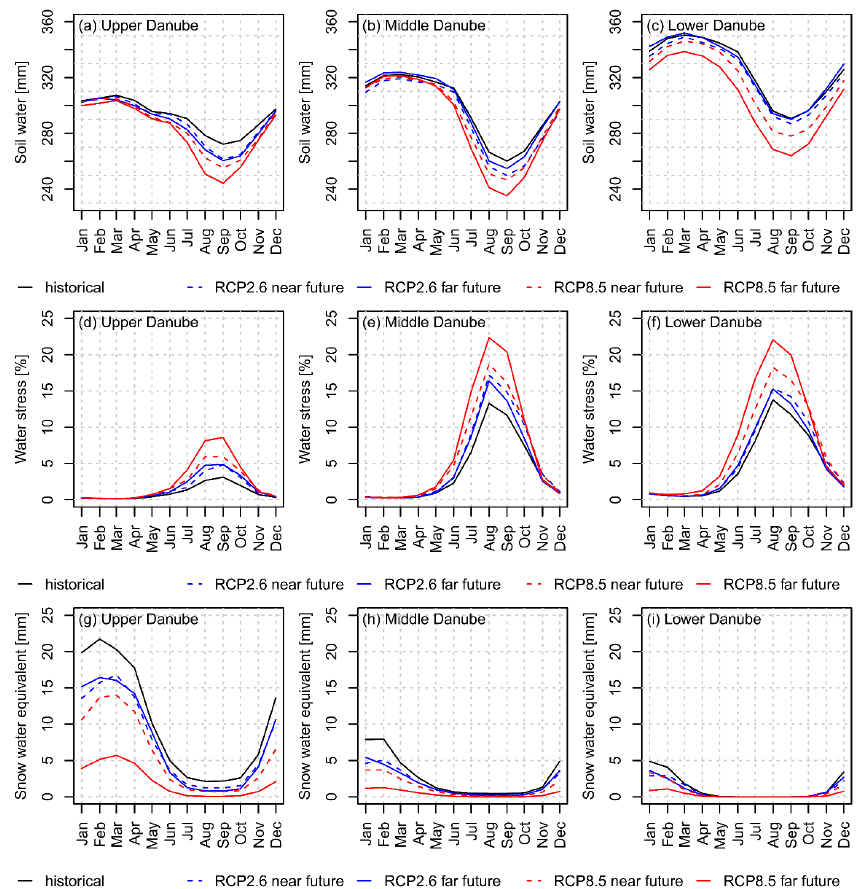
Figure 8. Long-term mean monthly developments of soil water content in the rooted zone [mm] ( a – c ), plant water stress [% reduction of potential transpiration] ( d – f ) and snow water equivalent [mm] ( g – i ) according to the historical GCM-RCM-driven simulations (ensemble mean, 1971–2000) and the GCM-RCM-driven simulations (ensemble mean) under RCP2.6 and RCP8.5 for the near future (2031–2060) and the far future (2071–2100) on spatial average over the Upper, Middle and Lower Danube.